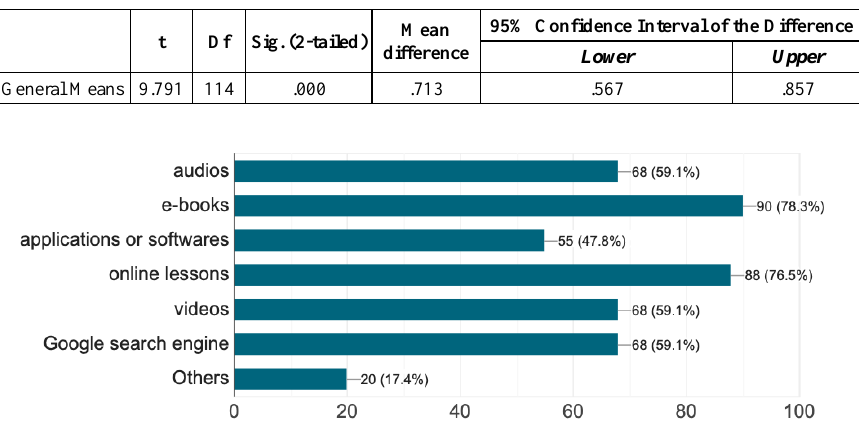
Table 2. One-sample t-test of general means (Test value = 3)